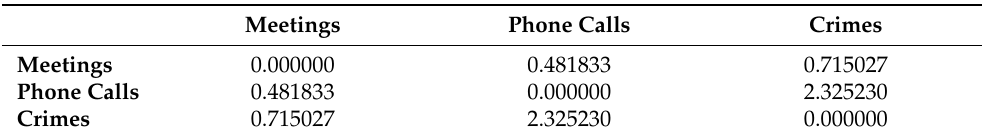
Table 8. Dissimilarity between degree distributions in the three layers of the Montagna multiplex network, computed using the Jeffreys dissimilarity